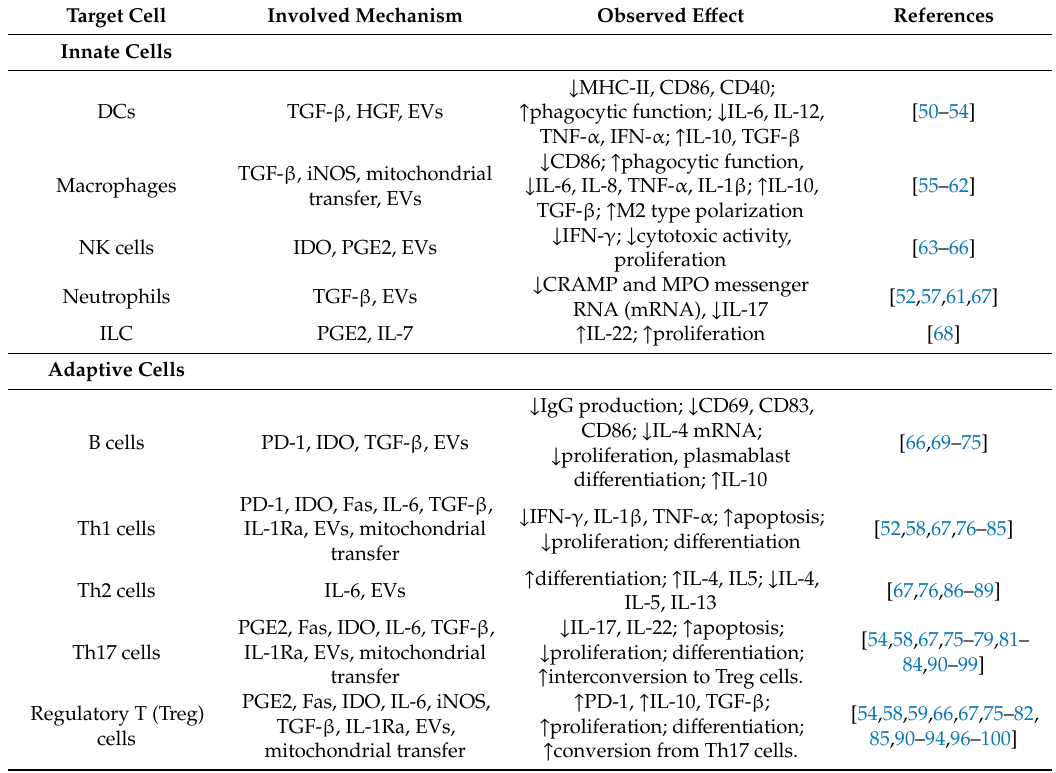
Table 1. Mechanisms of mesenchymal stem cell (MSC) immunosuppression on immune cells. Recapitulation of recent reports describing the known mechanisms via which MSCs exert suppressive function to di ff erent immune